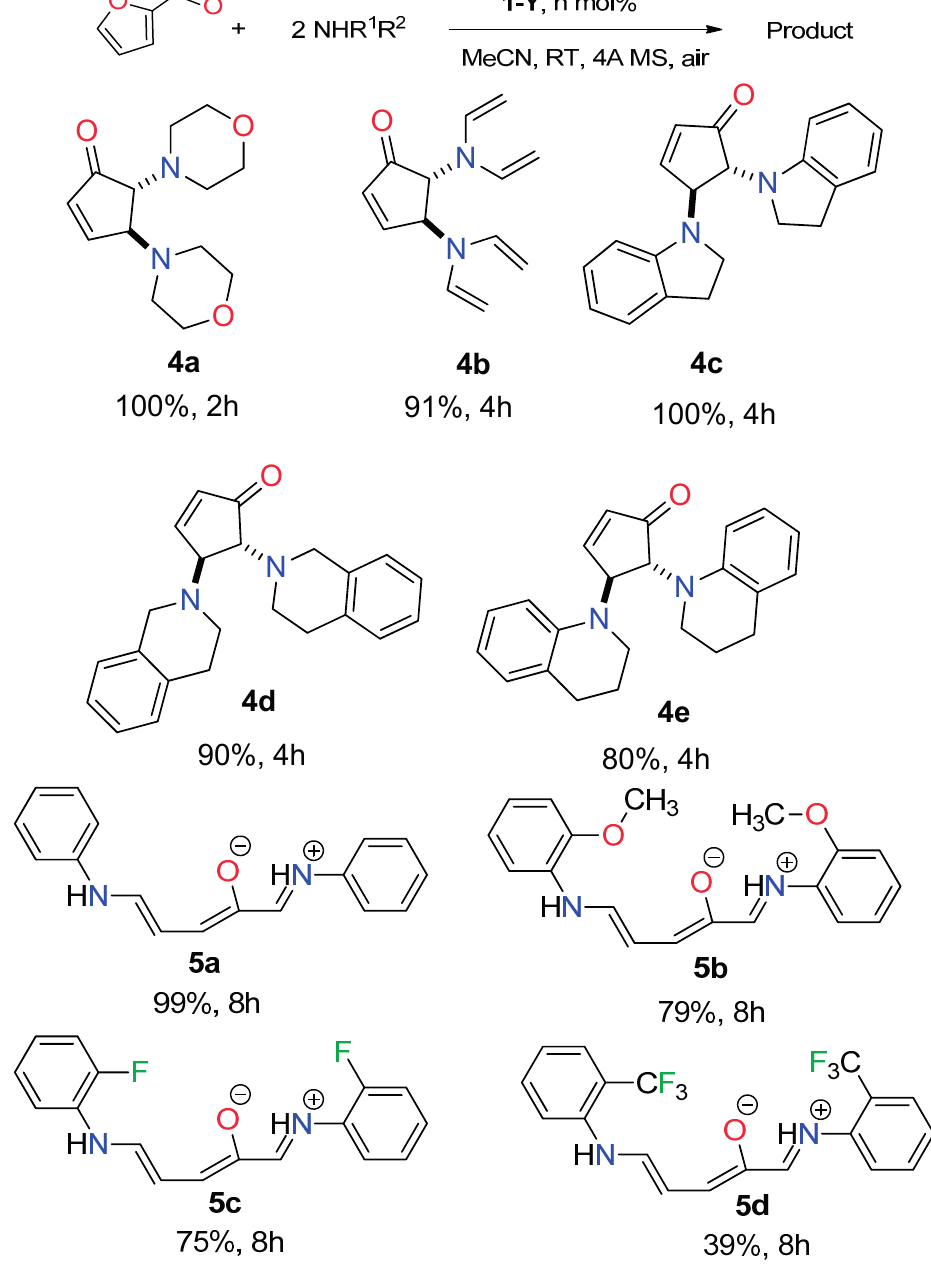
Table 2. Y(III)-catalysed condensation/ring-opening/cyclisation of secondary amines with 2-furaldehyde and condensation/ring opening of primary amines with 2-furaldehyde.